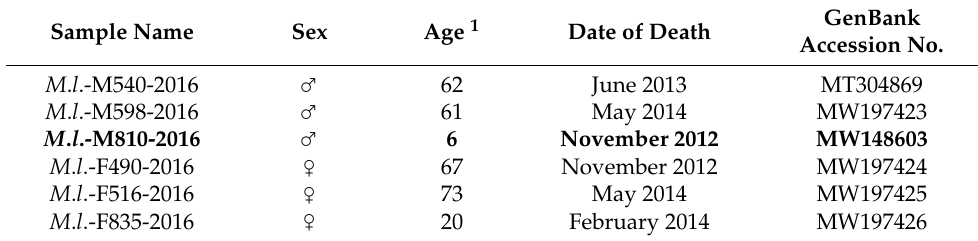
Table 8. Characteristics of samples used in the